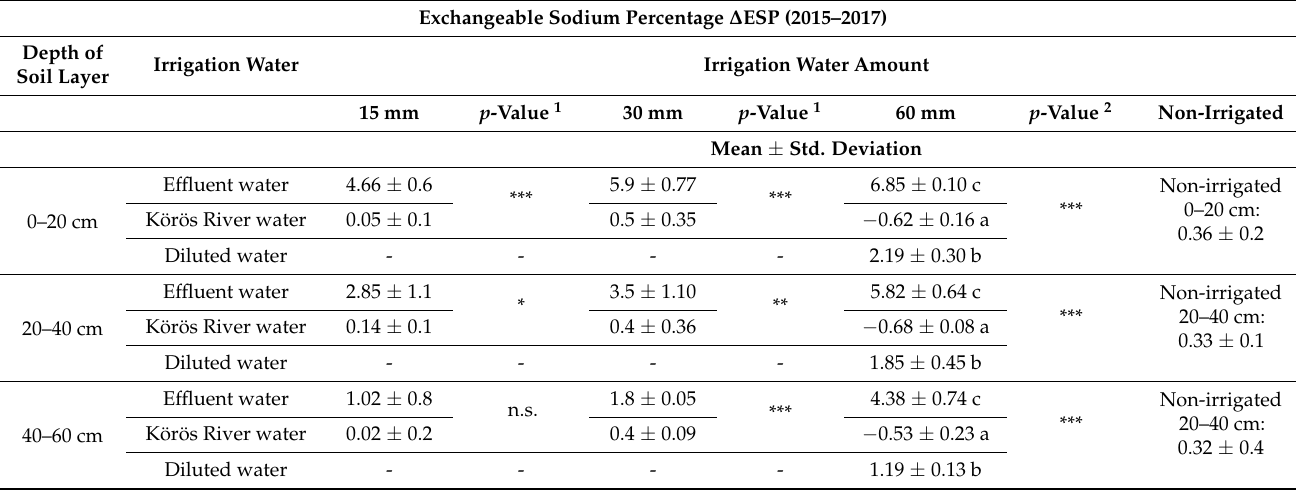
Table 4. Changes of the exchangeable sodium adsorption ratio between 2015 (before experiment) and 2017 (after experiment). Exchangeable Sodium Percentage ∆ ESP (2015–2017)